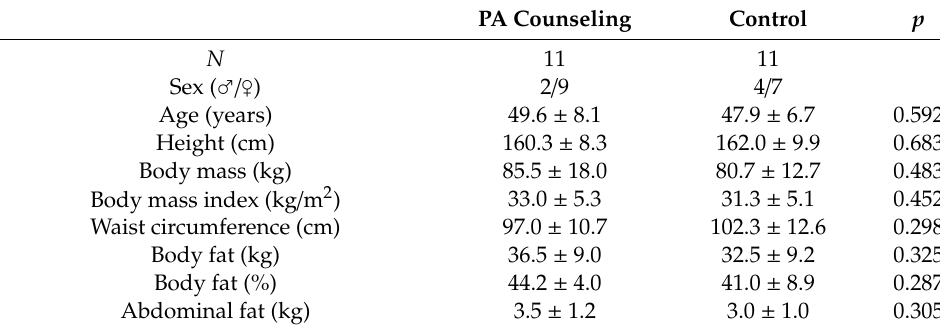
Table 1. Characteristics of the participants ( n =